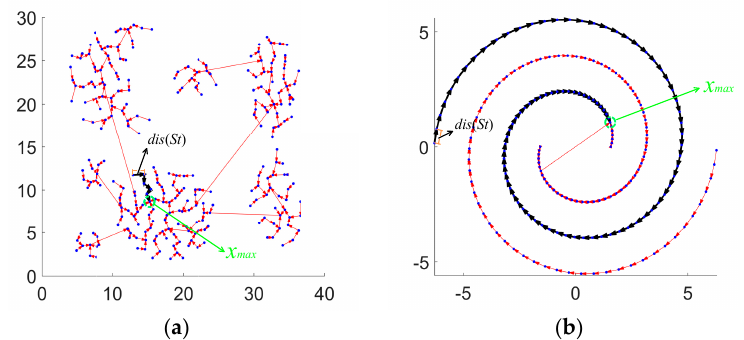
Figure 5. All chains in two datasets with different characteristics: ( a ) chains in a dataset of spherical clusters; ( b ) chains in a dataset of nonspherical clusters.